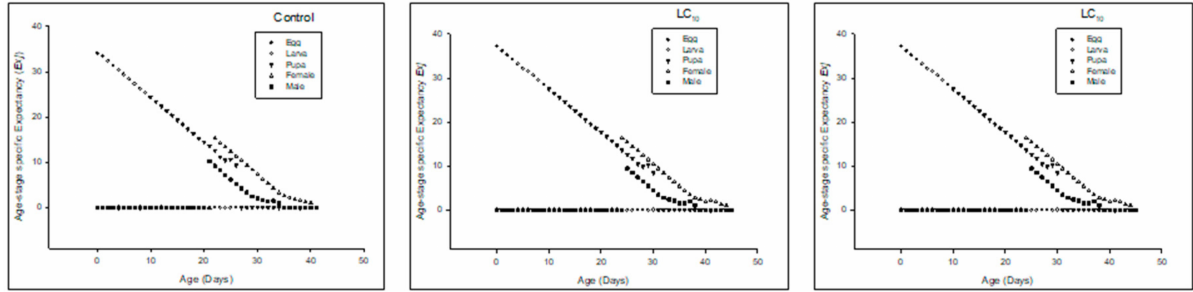
Figure 2. Age stage life expectancy ( e xj ) of the F 0 generation in Spodoptera frugiperda